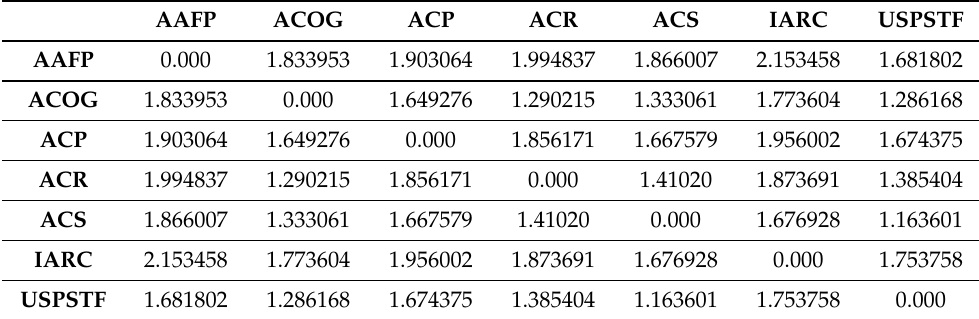
Table 5. This table shows the word mover’s distances between the guidelines using BioASQ embed- dings. This model also performed very well on the datasets in the Appendix A.